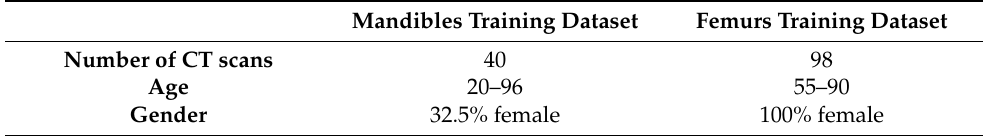
Table 1. Details of mandibles and femurs